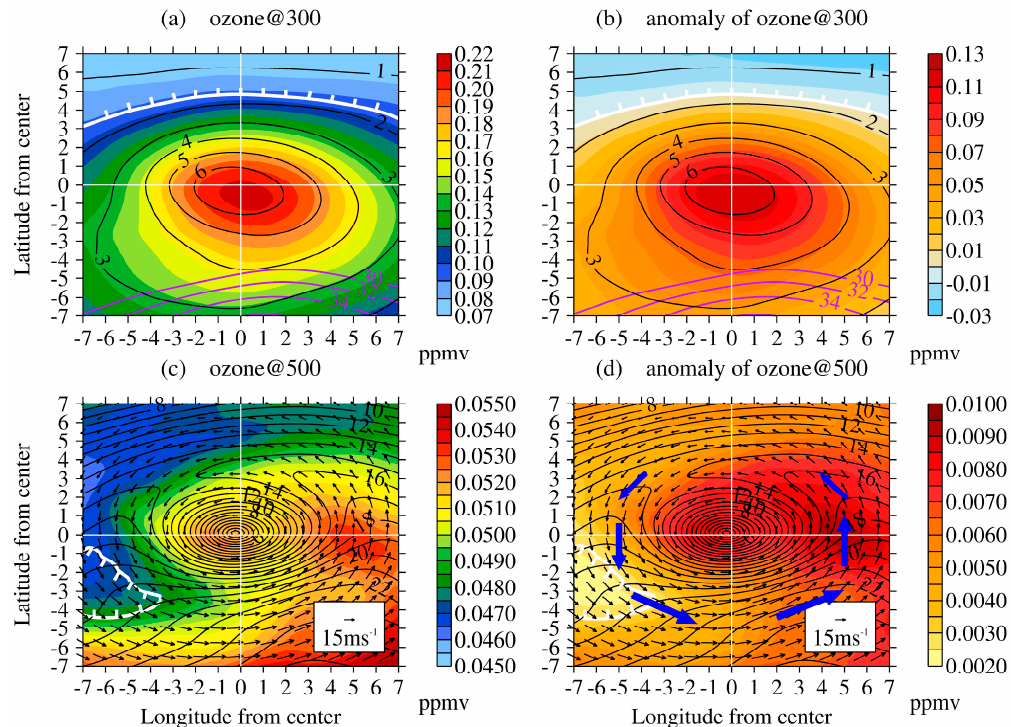
Figure 3. The statistical synthesis of the ozone concentration ( a ) and ( c ), unit: ppmv) and ozone anomalies (relative to the 11-year average ozone, ( b ), ( d ), unit: ppmv) in the research region at the time when COLs reached their maximum intensity at 300 and 500 hPa. The regions “downhill” of the white thick contour (in the direction of the ticks) did not meet the 95% confidence level following a t- test. Potential vorticity (black contour, unit: PVU) and jet stream (gray contour, > 30 m / s, unit: m / s) superposed on 300 hPa, and the horizontal wind (vector) and horizontal wind speed (black contour, unit: m / s) superposed on 500 hPa. The horizontal axis is longitudinal from the center, and the vertical axis is latitudinal from the center. The origin is at the center point of the